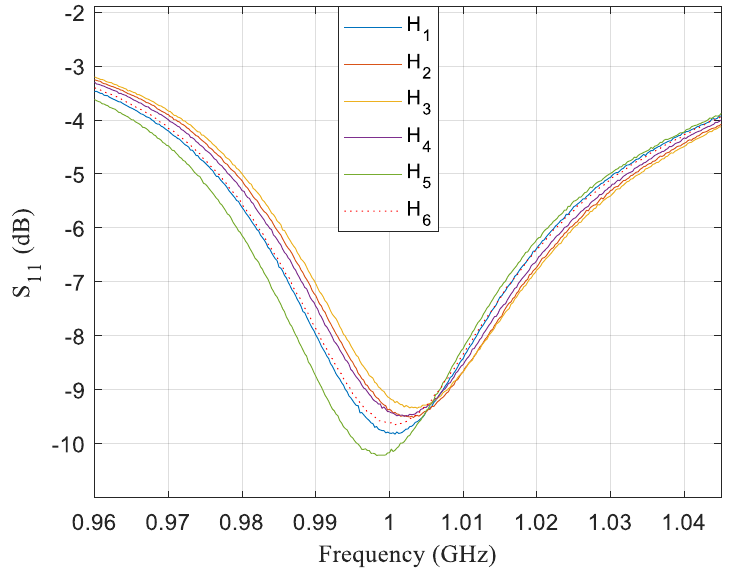
Figure 6. Frequency response of a sensor for a single test where the sensor is configurated in a conventional zone for six honey samples. Frequency responses obtained for the different samples are almost identical, while differences are practically negligible. There is a variation in insertion losses of just 1 dB and in frequency resonance of only 6 MHz at most. In addition, the amplitudes of insertion losses are ~ −9.5 dB. Even though they are acceptable, they also are ordinary.